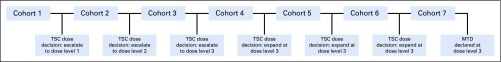
Trial Steering Committee (TSC) dose decisions by cohort. MTD, maximum tolerated dose.